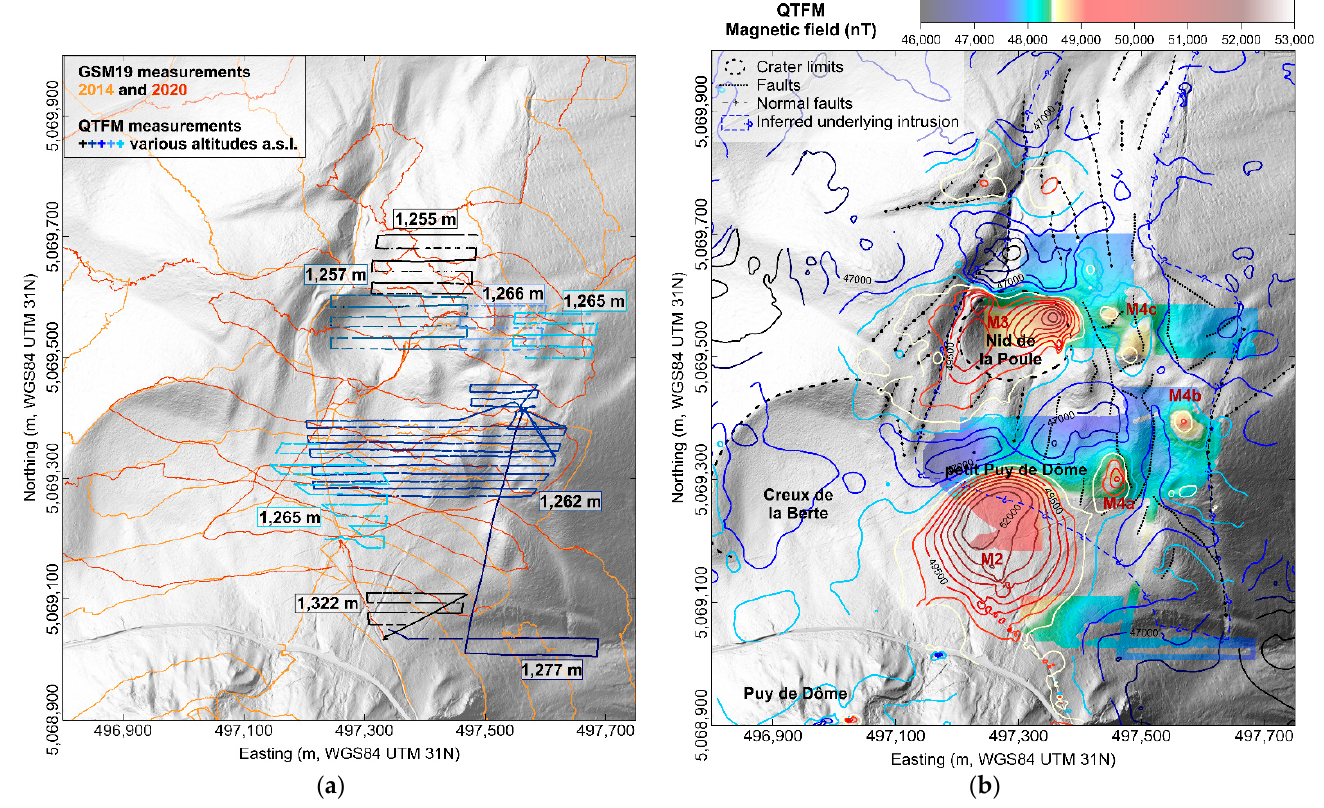
Figure 4. ( a ) Location of the magnetic measurements on the scale of the petit Puy de Dôme volcano. ( b ) QTFM total magnetic field interpolated and gridded at an averaged altitude (grid cell: 2 m). The GSM19 total magnetic field is superimposed as isocontours (500 nT spacing, same grid cell size and color scale).